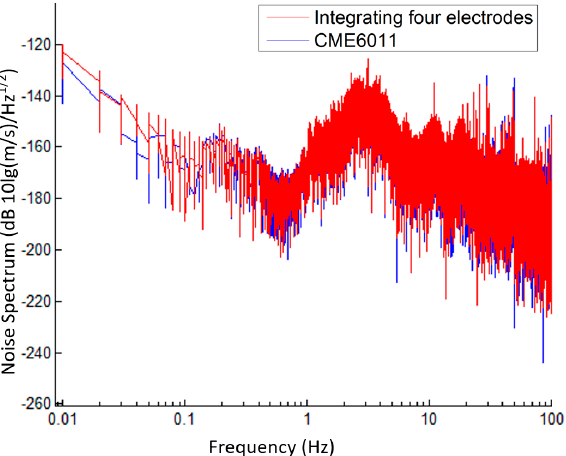
Figure 8. The noise spectrum density results of the fabricated electrochemical seismometer with four electrodes integrated on one chip in comparison with the commercial counterpart of